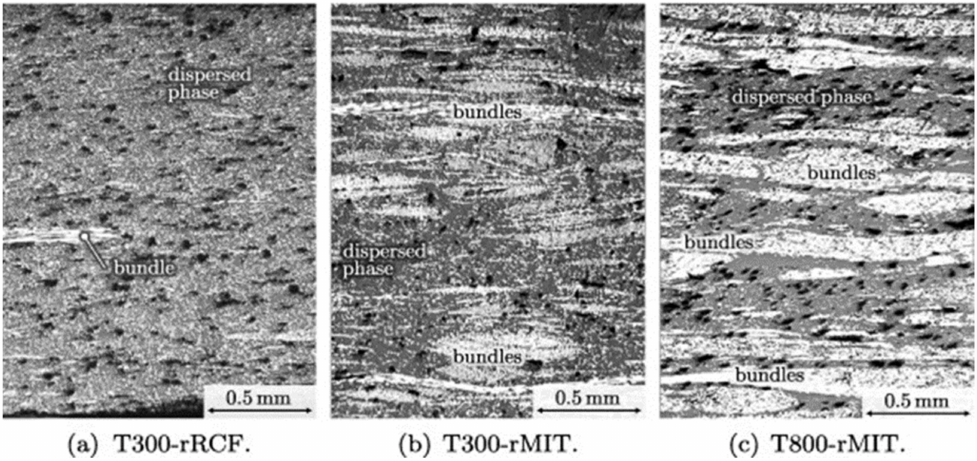
Figure 4. Microstructure of recycled carbon fiber composites from wet-laid textiles. Reprinted with permission from [62]. Copyright 2014